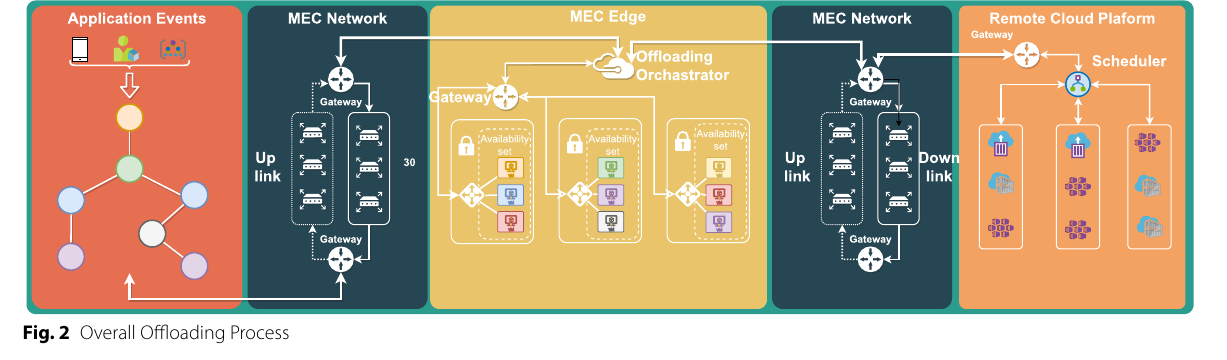
Fig. 2 Overall Offloading Process